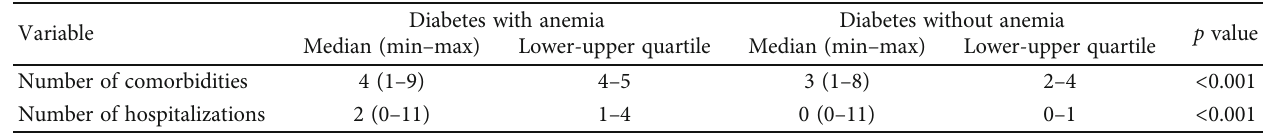
Table 2: Di ff erences in the number of comorbidities and the frequency of